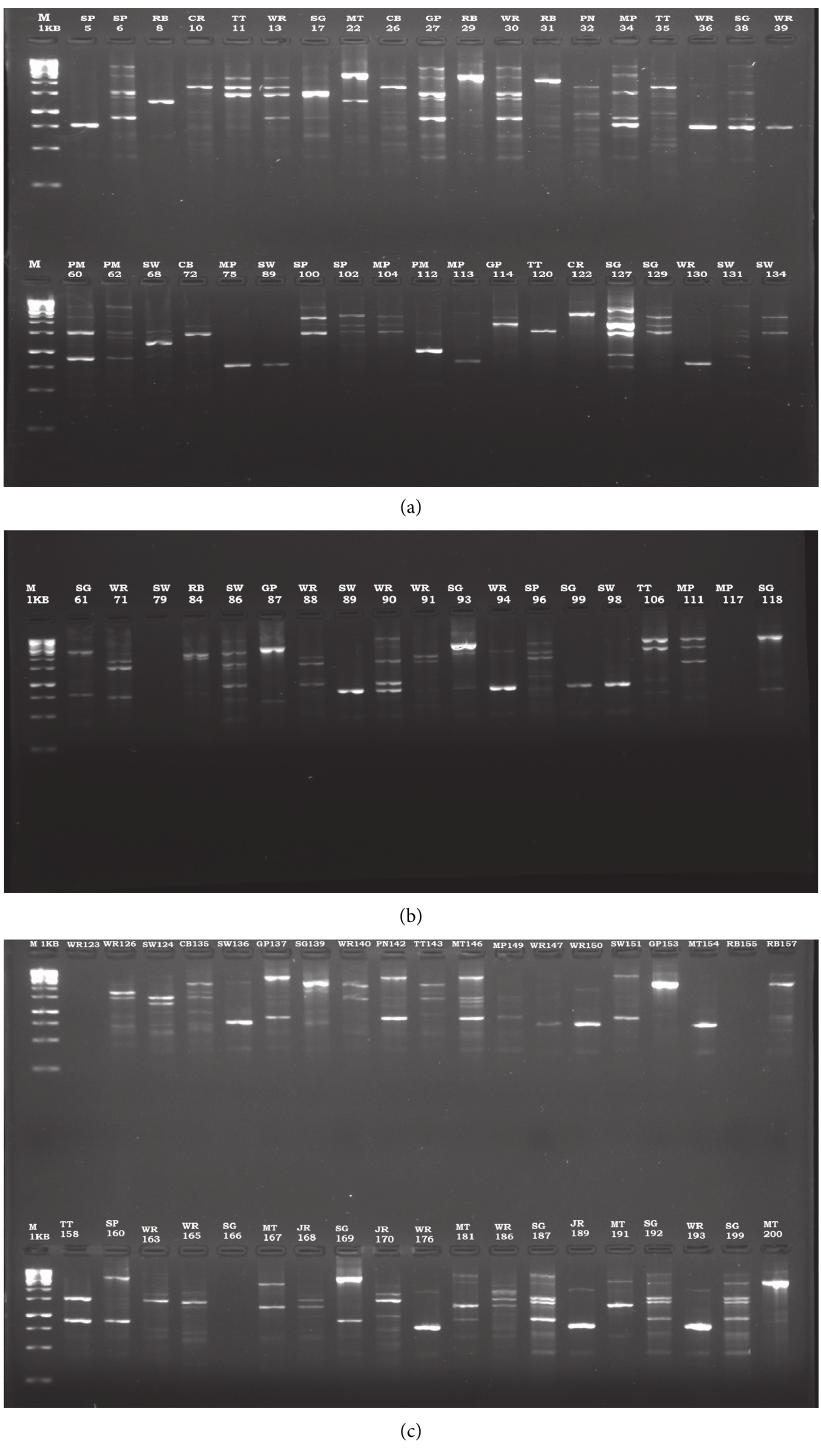
Figure 1: Agarose gel electrophoresis for RAPD-PCR profiles obtained with primer OPR13 for strains in the B. cereus group. M: marker, WR: white rice, JR: jollof rice, TT: smoked titus, GP: green pea, SG: spaghetti, RB: runner bean, MP: meat pie, CR: carrot, MT: meat, CB: cabbage, SW: smoked African chad, SP: sweet pepper, and PN: smoked blue